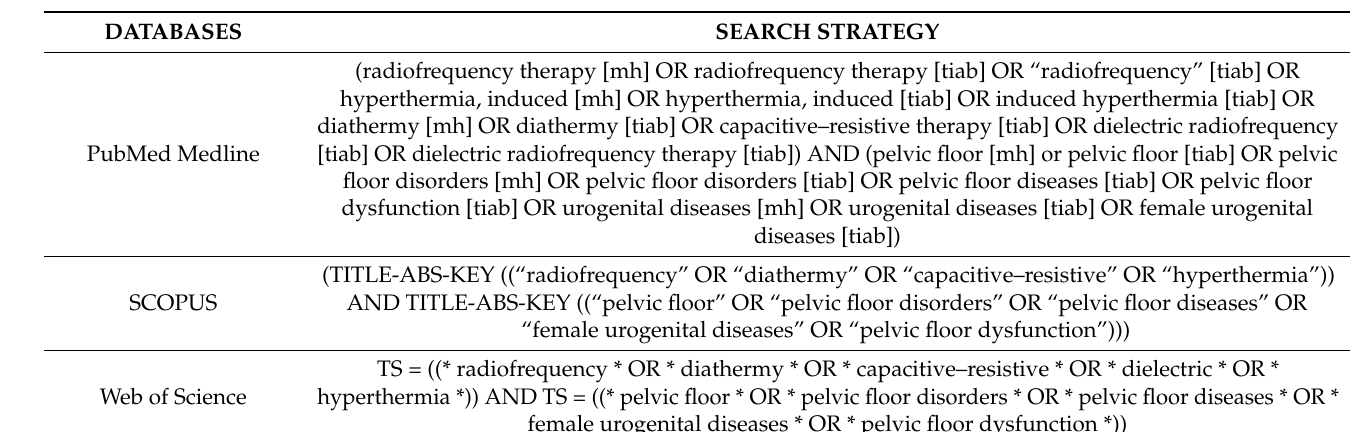
Table 1. Bibliographic search strategy used in each